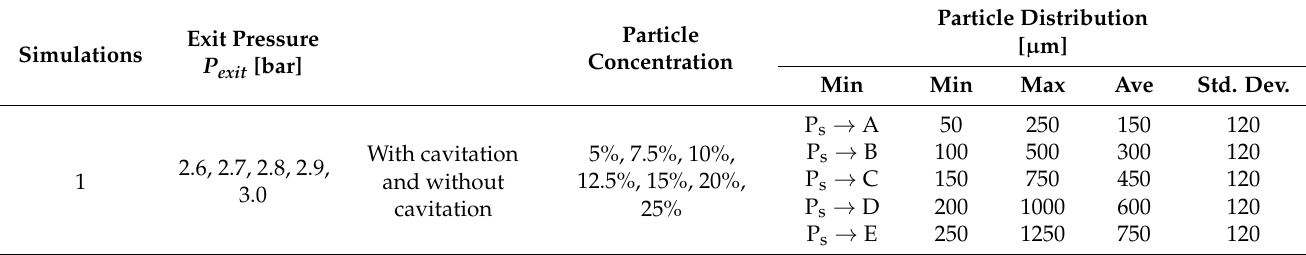
Table 1. List of the simulations conducted for the current